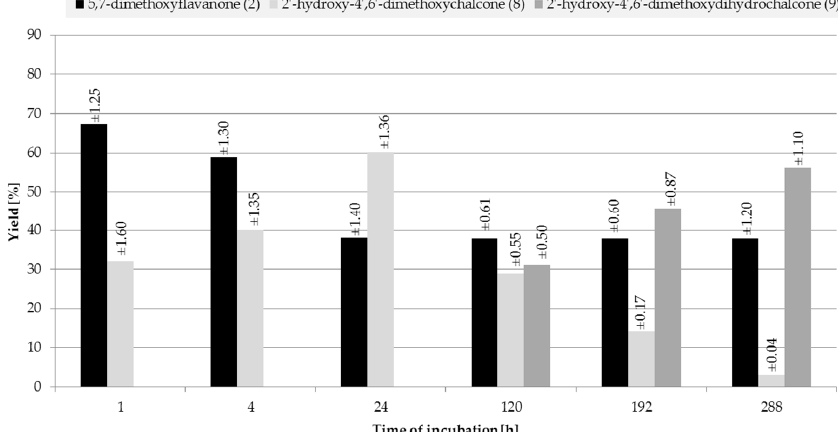
Figure 2. Biotransformation of 5,7-dimethoxyflavanone ( 2 ) in S. maltophilia KB2 culture; the yield (%) of the products was determined by HPLC.